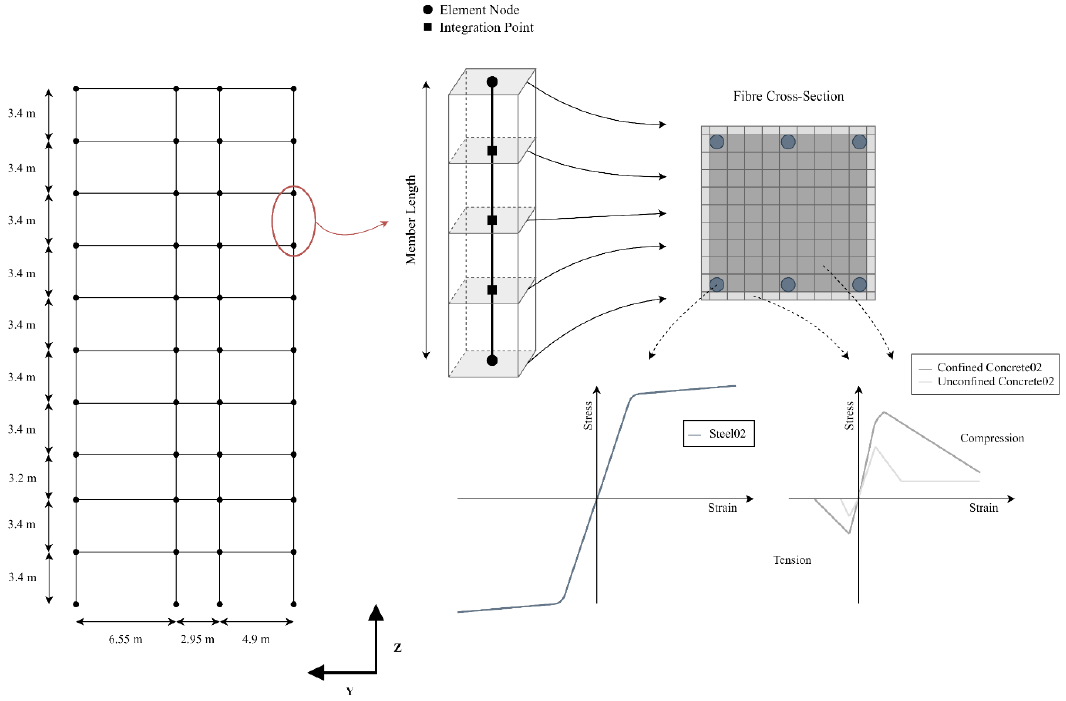
Figure 2. Side view of the 3D numerical model of the hospital building, elements, and fiber sections discretization.